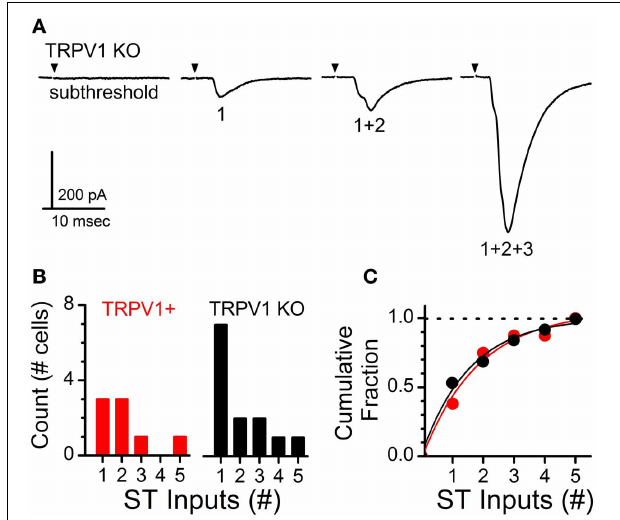
FIGURE 3 | Analysis of primary afferent innervation patterns onto second-order NTS neurons from control and TRPV1 KO animals. (A) Current traces showing increasing stimulus intensity recruiting a single contact followed by multiple convergent ST afferent inputs. Traces are of individual sweeps with the black arrow indicating the time of ST activation. The stimulus artifacts have been removed. Activation of multiple inputs produces a compound waveform; with individual inputs discriminated by shock intensity at activation, latency, and amplitude. (B) Histogram detailing the total number direct ST inputs across recorded neurons from each group. (C) Cumulative proportion showing no significant difference in the percentage of neurons receiving 1 or > 1 inputs between control and TRPV1 KO animals ( P = 0 . 63, Wilcoxon ranked sum test). Dashed line provides reference to 1.0 on the vertical